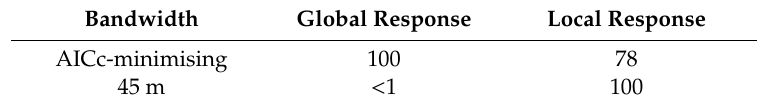
Table 4. Percentage of 500 simulations in which the correct model was identified by model selection.